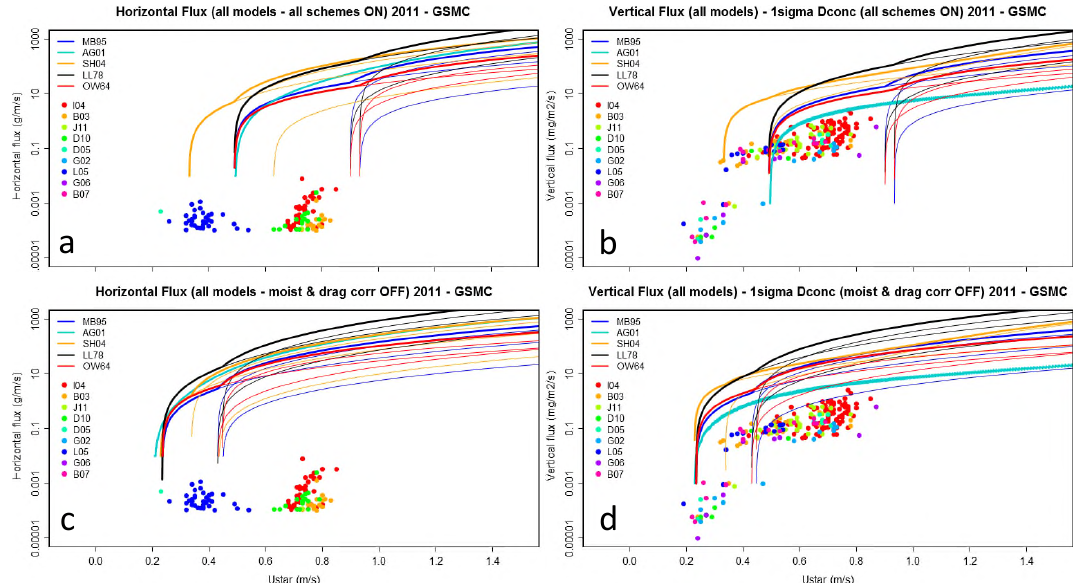
Figure 5. Horizontal and vertical emission fluxes for Exps. 1a–5a (a, b) and Exps. 1d–5d (c, d) . Bold lines are the sum of the flux over all four size bins. Thin lines are individual model particle size categories (fine/medium sand is emitted first). Coloured circles are the field